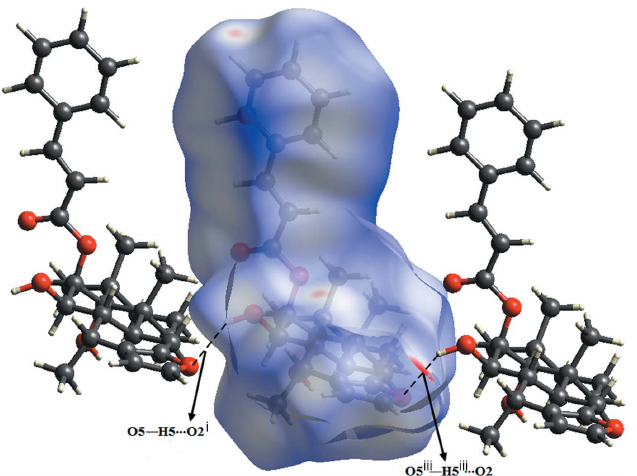
Figure 5 Hirshfeld surface mapped over shape-index calculated for the title compound.